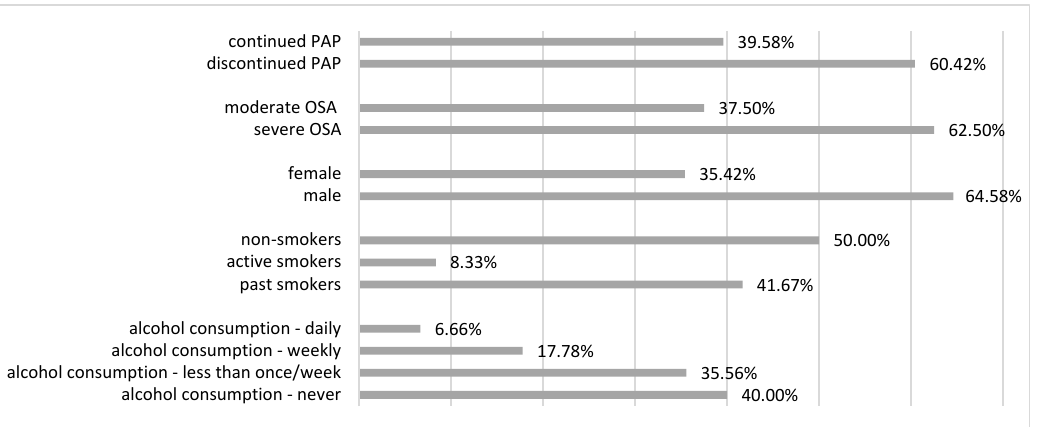
Figure 2. Follow-up demographic and clinical characteristics of our study group. PAP: positive airway pressure; OSA: obstructive sleep apnea. Our two subgroups (adherent and nonadherent to PAP) were homogenous regarding the baseline clinical parameters, quality of life and daytime sleepiness, p > 0.05 (Table 1). Table 1. Baseline clinical, anthropometric, quality of life and daytime sleepiness parameters.